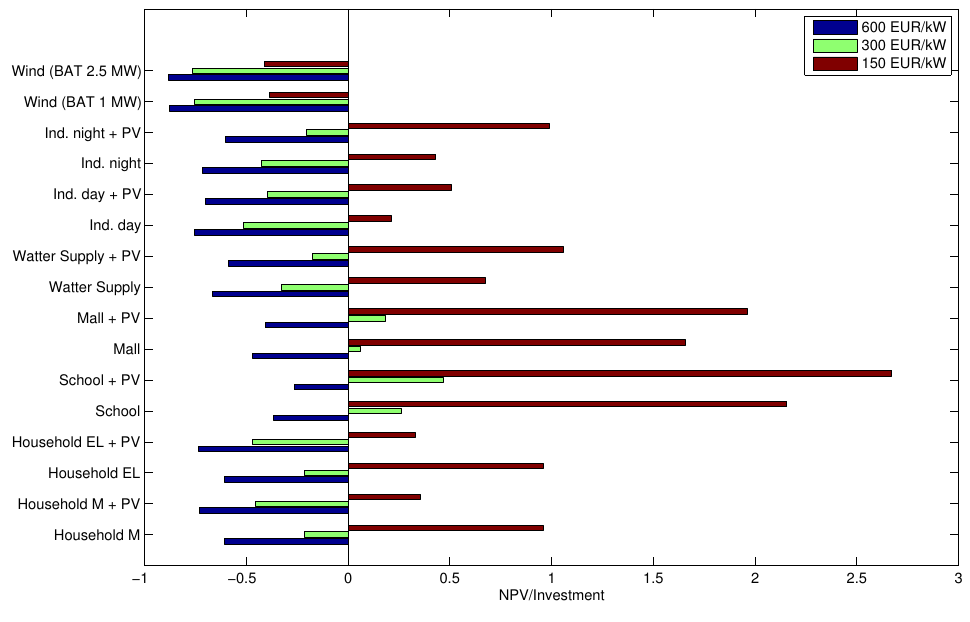
Figure 11. NPV/Investment Ratio for different end-users and battery capital costs using suppliers’